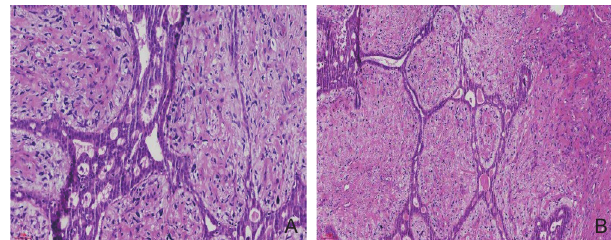
Figure 4 Photomicrographic inspection revealed a borderline phyllodes tumor with increase in stromal cellularity, moderate atypia, and occasional mitoses. Hematoxylin-eosin staining: (A) Magnification, 40×; (B) Magnification, ×20.